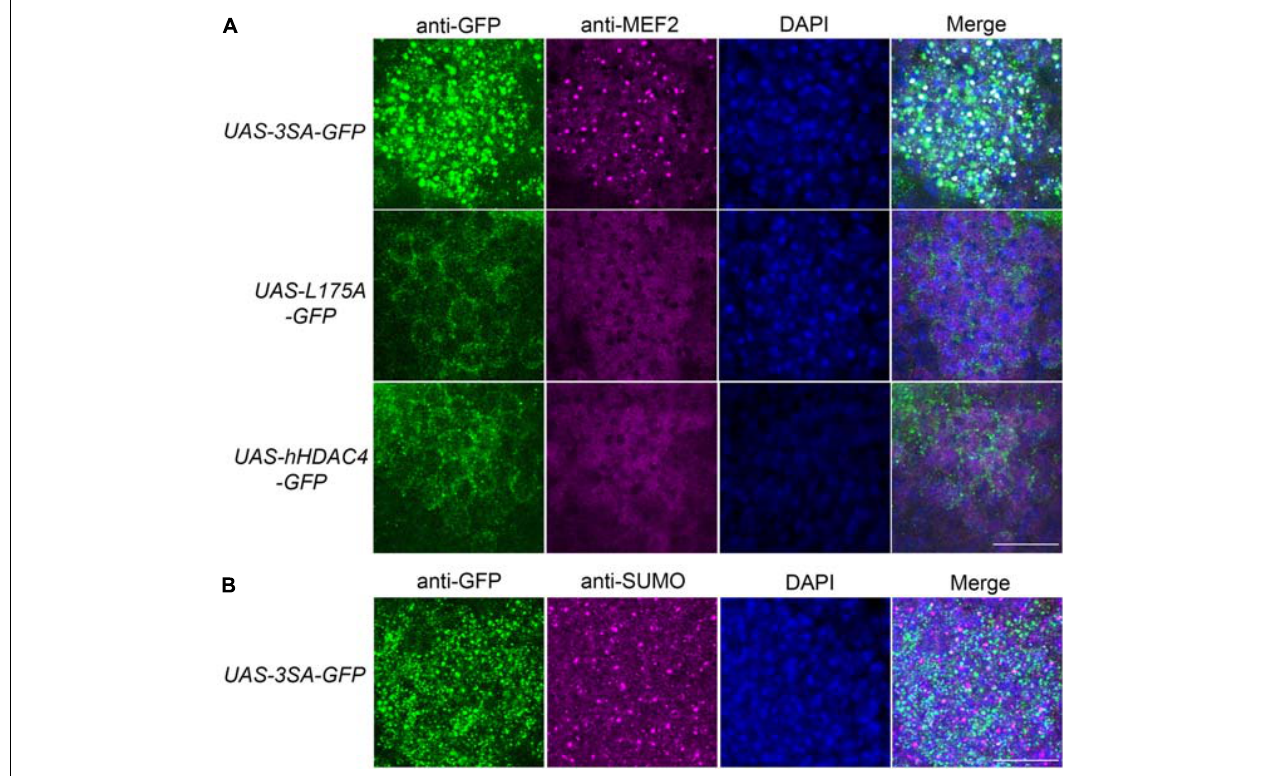
FIGURE 5 | 3SA distributes with MEF2 but not SUMO in nuclei. All genotypes were generated by crossing tubP-GAL80ts; OK107-GAL4 females to males of the indicated genotype. Expression was induced in the adult brain by raising the flies at 18 ◦ C and placing at 30 ◦ C 72 h prior to dissection. Representative images from each genotype are shown. Z-stacks were captured of 0.25 µ m slices, which were imaged at × 100 magnification. Whole-mount brains were subjected to immunohistochemistry with anti-MEF2 (magenta) and anti-GFP (green); or anti-SUMO (magenta) and anti-GFP (green). The number of overlapping puncta in each section (white in the merged image) were counted using ImageJ in each of ∼ 40 sections through the Kenyon cell layer. (A) . 3SA co-distributes with MEF2 in nuclei. 3SA colocalised with MEF2 ( n = 7 brains, average number of puncta = 220 ± 9) whereas hHDAC4 ( n = 7 brains, average number of puncta = 0) and L175A ( n = 7 brains, average number of puncta = 0) did not. Scale bar = 10 µ m. (B) 3SA does not co-distribute with SUMO in nuclei ( n = 7 brains, average number of puncta = 0). Scale bar = 10 µ